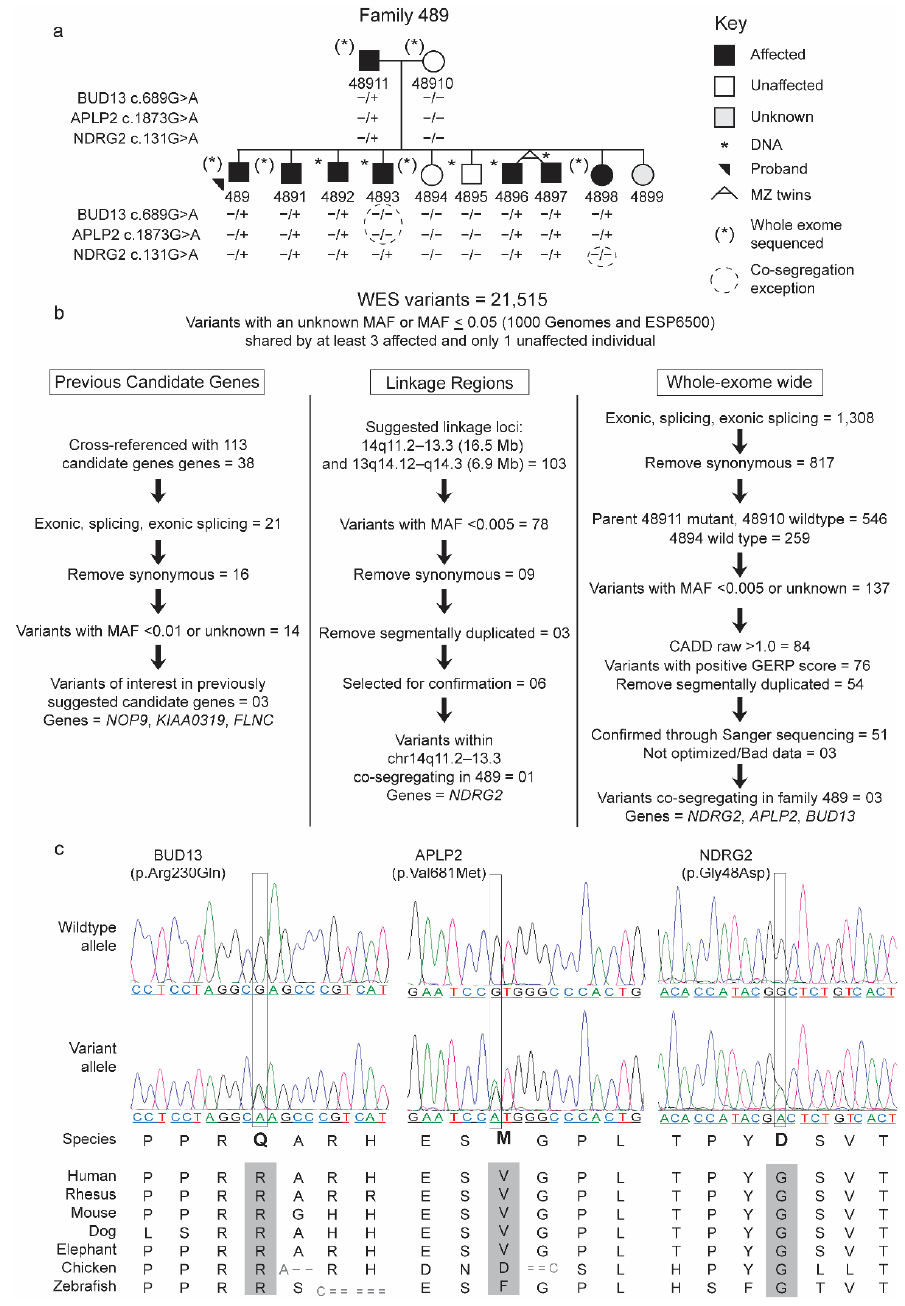
Figure 1. Prioritization of exome variants in family 489. ( a ) The family 489 pedigree and co- segregation of the three identified variants. ( b ) WES variant filtering workflow. WES—whole exome sequencing; MAF—minor allele frequency; CADD—combined annotation-dependent deple- tion; GERP—genomic evolutionary rate profiling. ( c ) Electropherograms showing the variant and wildtype alleles for the three identified variants with their conservation across